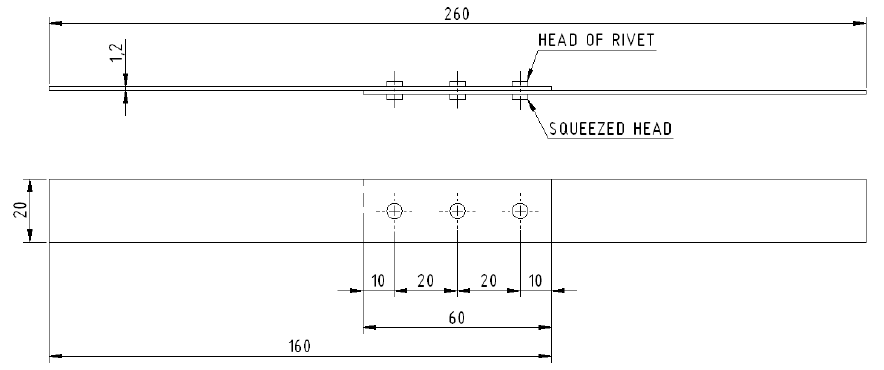
Figure 1. Test article geometry.